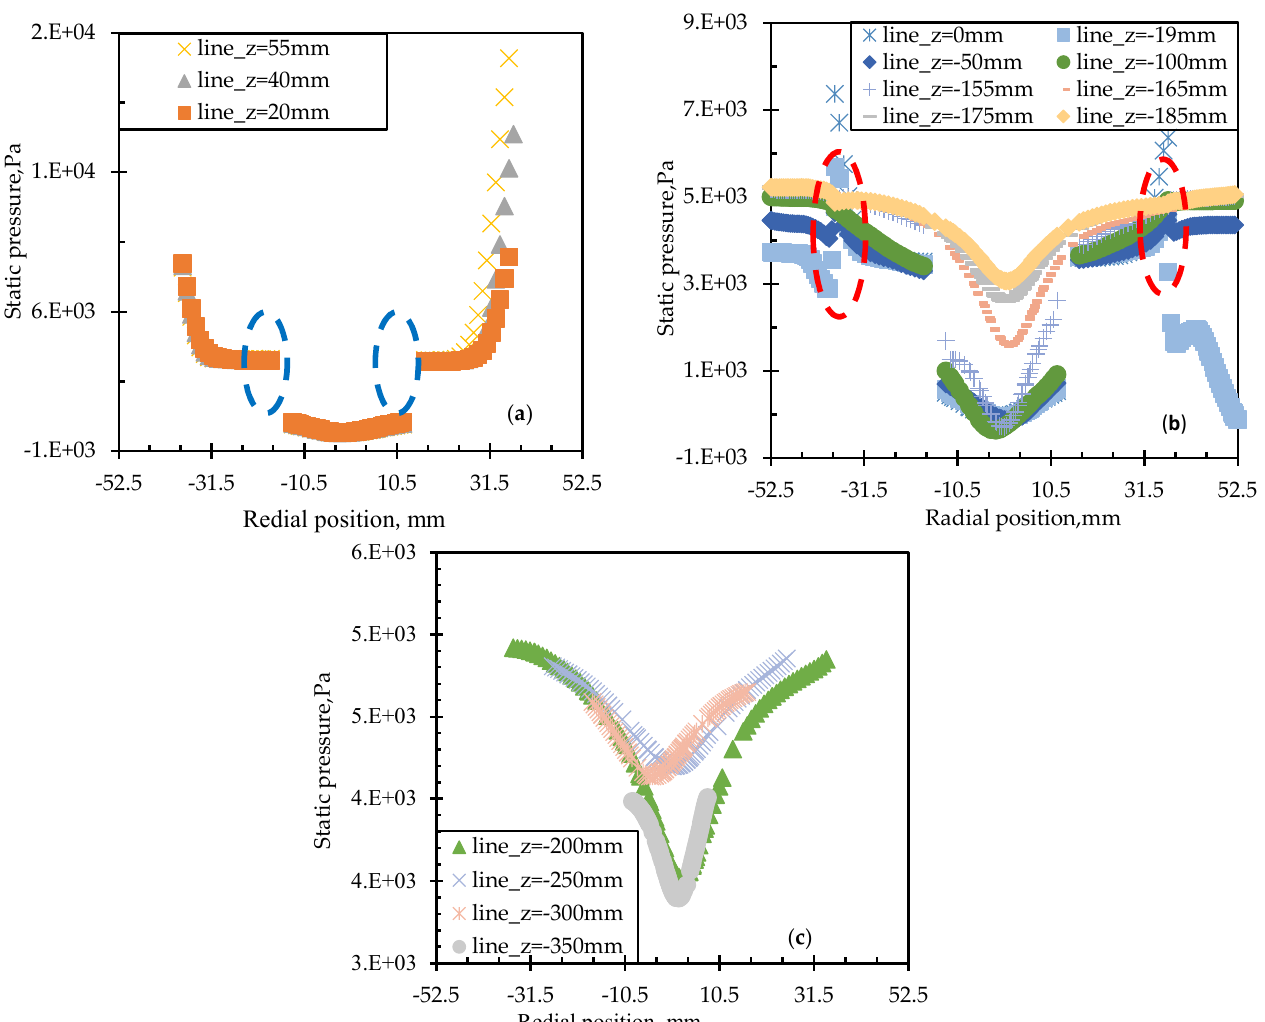
Figure 3. Contour of static pressure distribution: ( a ) front view and ( b ) back view in vertical planes (y = 0 mm and y=35 mm) and ( c ) different horizontal planes (z = 55 to -350 mm) in TPHS with the inlet velocity of 10 m/s.